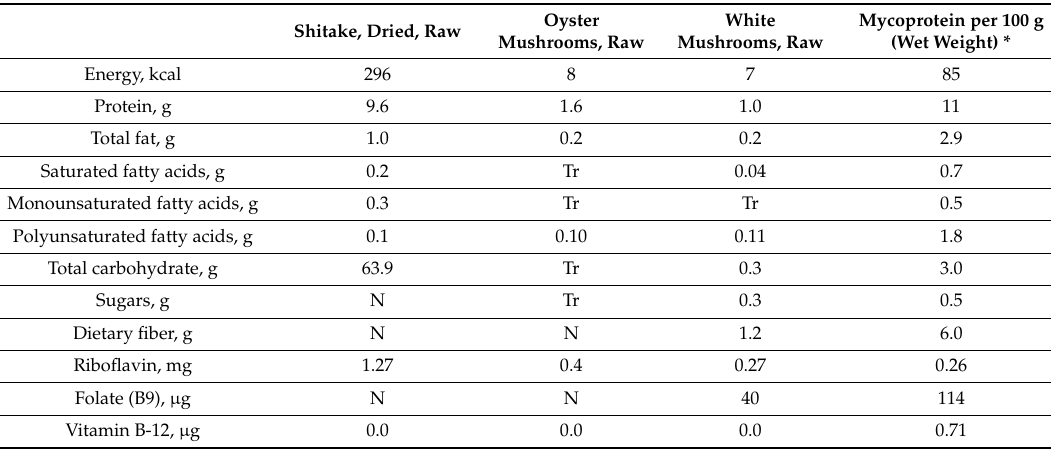
Table 2. Nutritional profile of fungal